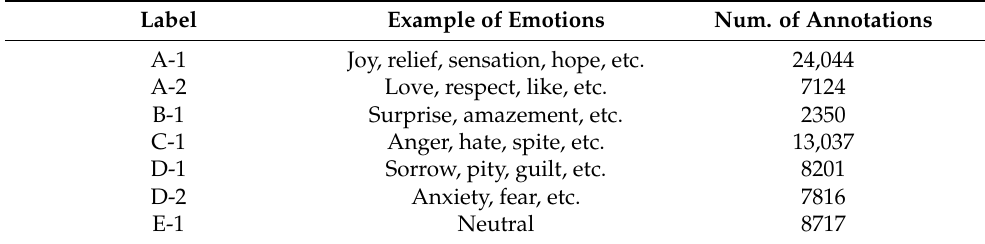
Table 2. Labels and number of annotations.